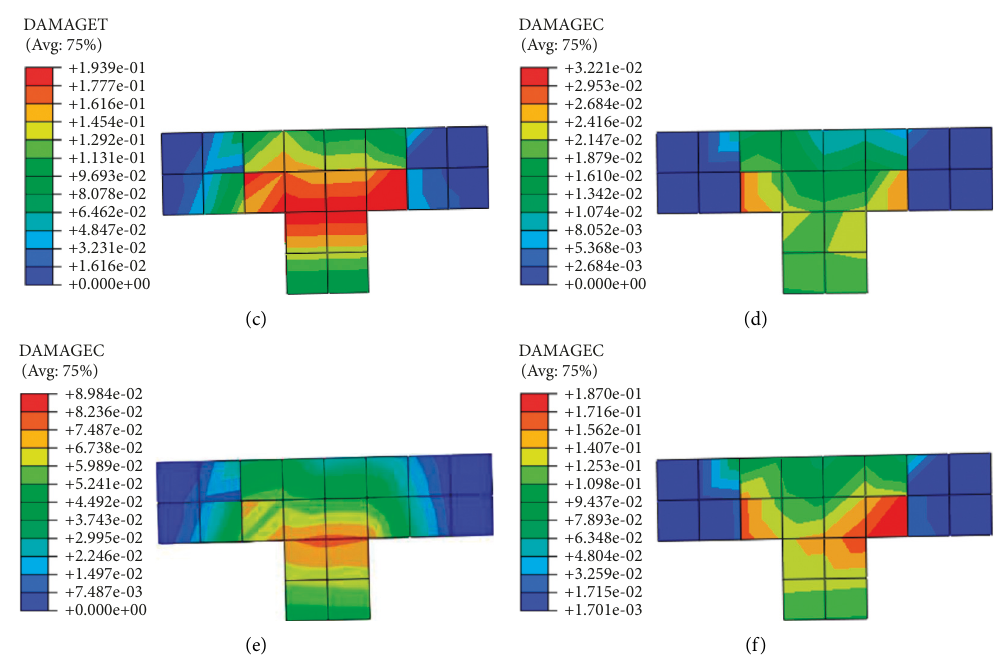
Figure 15: Damage contours under the loading of a negative temperature gradient. Tensile damage: (a) − 15 ° C/m, (b) − 30 ° C/m, and (c) − 45 ° C/m. Compression damage: (d) − 15 ° C/m, (e) − 30 ° C/m, and (f) − 45 °